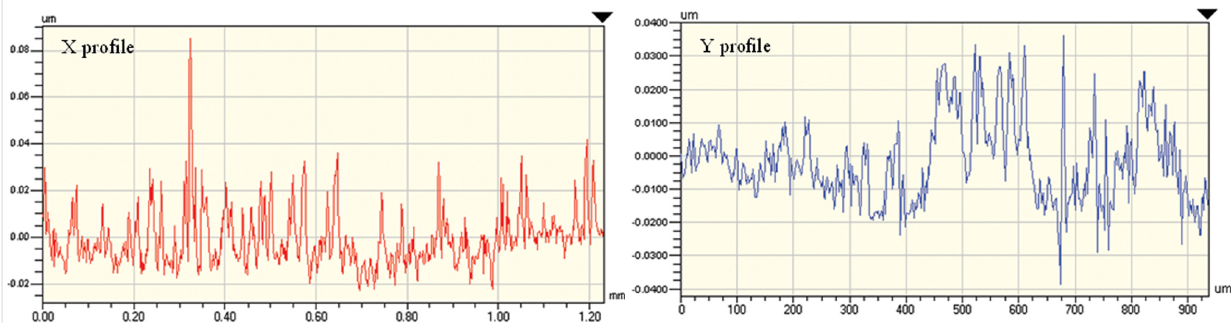
Figure 3. The roughness profiles of glass substrates.